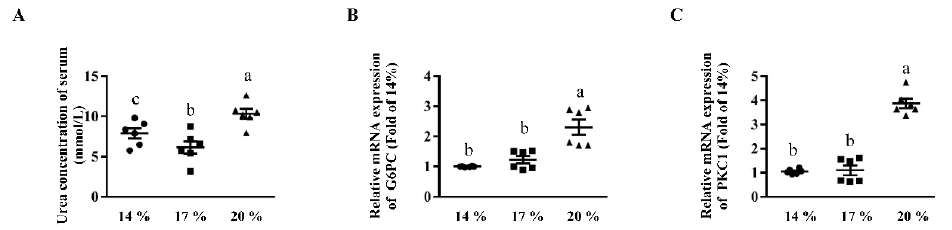
Figure A3. Effects of dietary crude protein level on hepatic lipolysis, and lipid oxidation. Immunoblot analysis of HSL ( A ) and PGC-1 α ( B ) protein abundances, LPL ( C ), and PPAR α ( D ) mRNA abundance in the liver of weaned piglets fed dif- ferent dietary crude protein. Values are means ± SEMs, n = 4 (protein abundance) or 6 (mRNA expression). Means without a common letter differ, p < 0.05. HSL, hormone-sensitive lipase; PGC-1 α , peroxisome proliferator-activated receptor gamma coactivator 1-alpha; LPL, lipoprotein lipase; PPAR α , peroxisome prolifera-tor-activated receptor alpha.